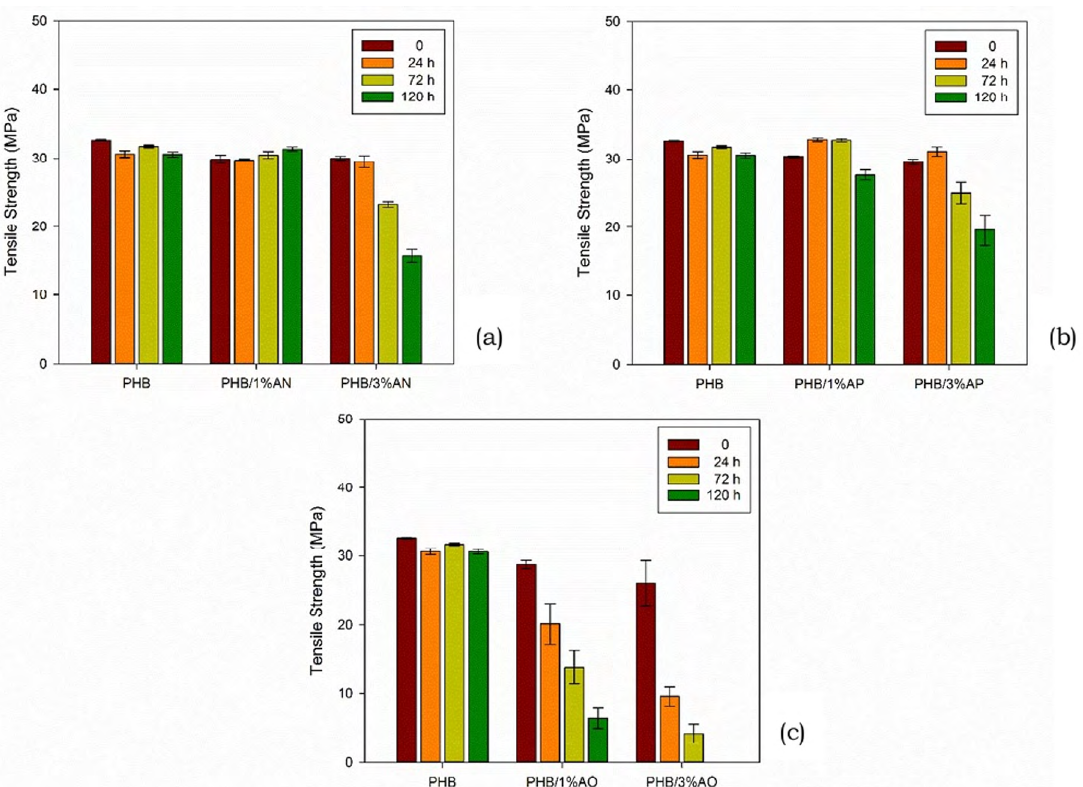
Figure 7. Effect of thermal aging at 115ºC for indicated times on the tensile strength of PHB and PHB compounds with natural (a), purified (b) and, purified/organophilized Bentonite (c).